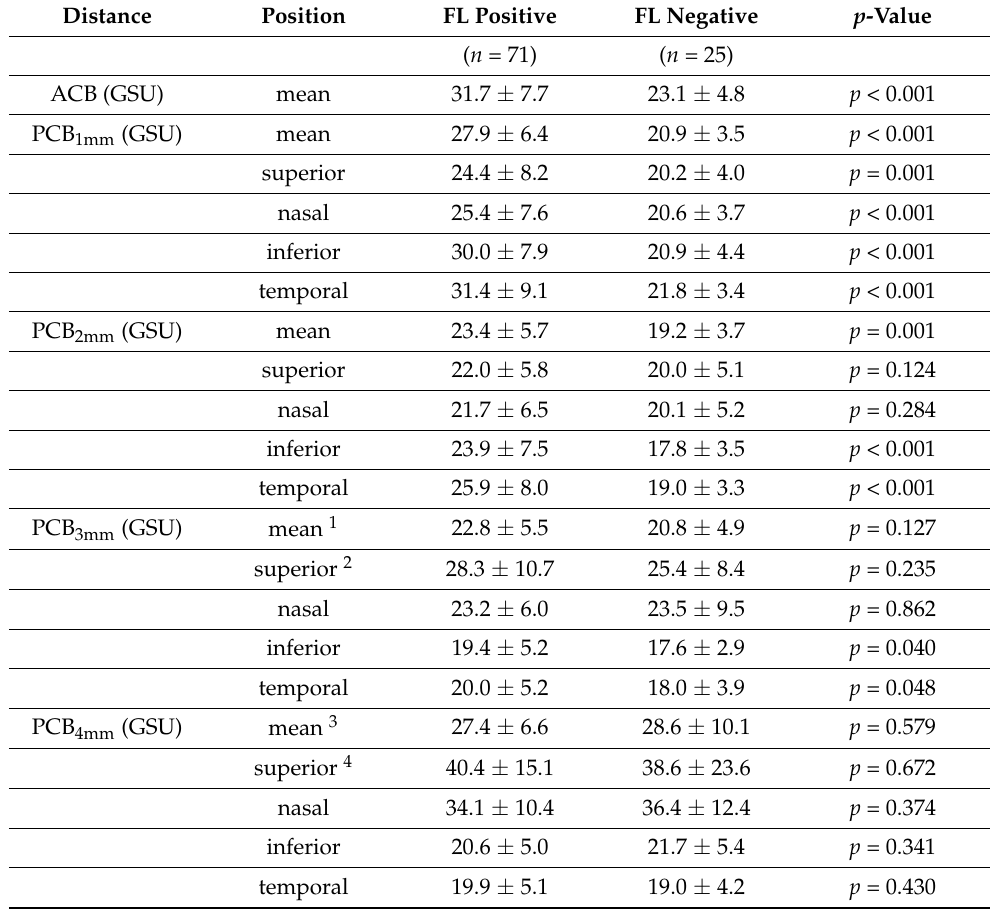
Table 2. Focal backscatter in fibrillar layer (FL)-positive and -negative advanced FECD eyes: The en face Scheimpflug backscatter plane with the highest backscatter gray scale unit (GSU) at the corneal apex within the posterior corneal 100 µ m was selected, and focal backscatter values were extracted at the given locations. Apex corneal backscatter (ACB), peripheral corneal backscatter (PCB). Distance Position FL Positive FL Negative p -Value ( n = 71) ( n = 25) ACB (GSU) mean 31.7 ± 7.7 23.1 ± 4.8 p < 0.001 PCB 1mm (GSU) mean 27.9 ± 6.4 p < 0.001 superior